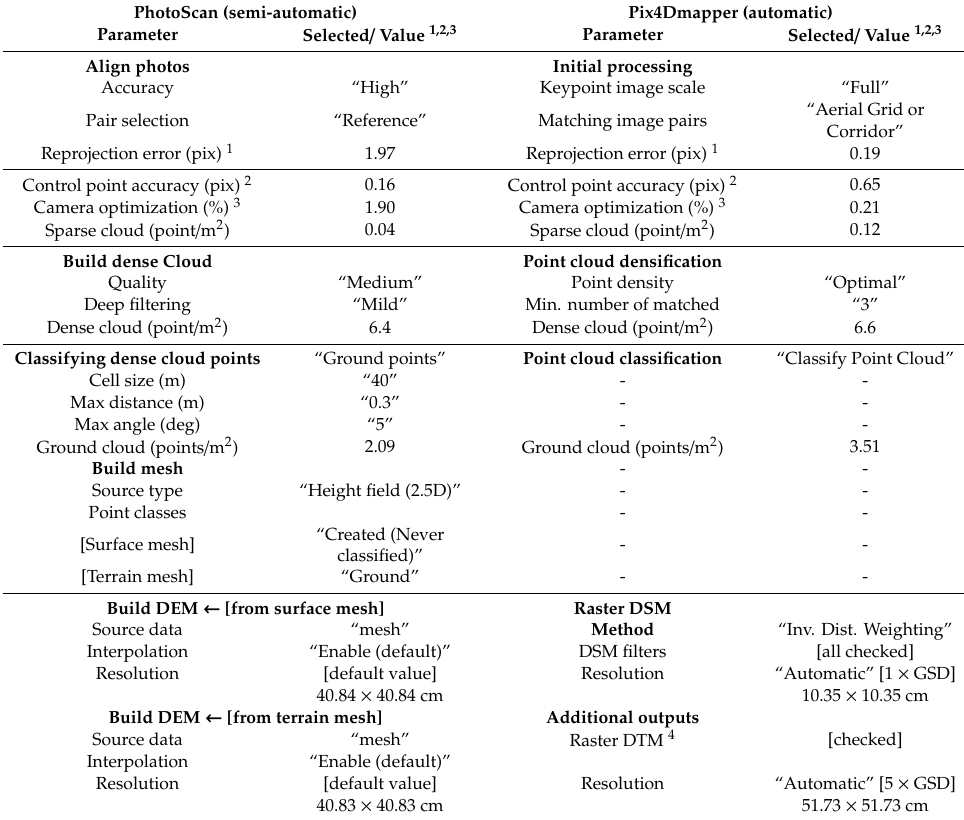
Table 2. Settings for the SfM-MVS processing chain of UAV-based image with the applied